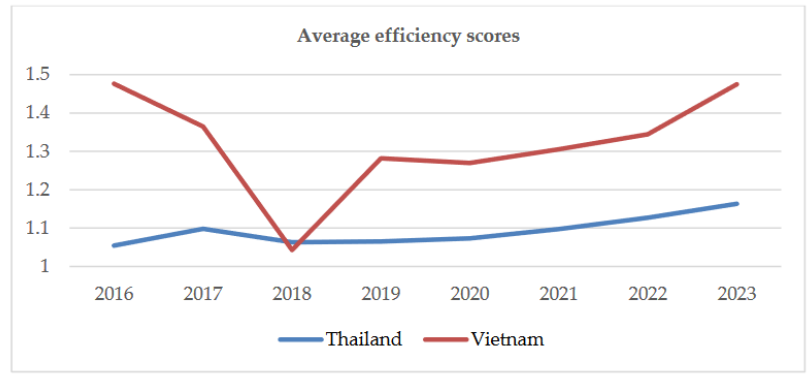
ffi ciency score over the period of 2016 to 2023. Figure 6. Efficiency score over the period of 2016 to 2023. Figure 6. E